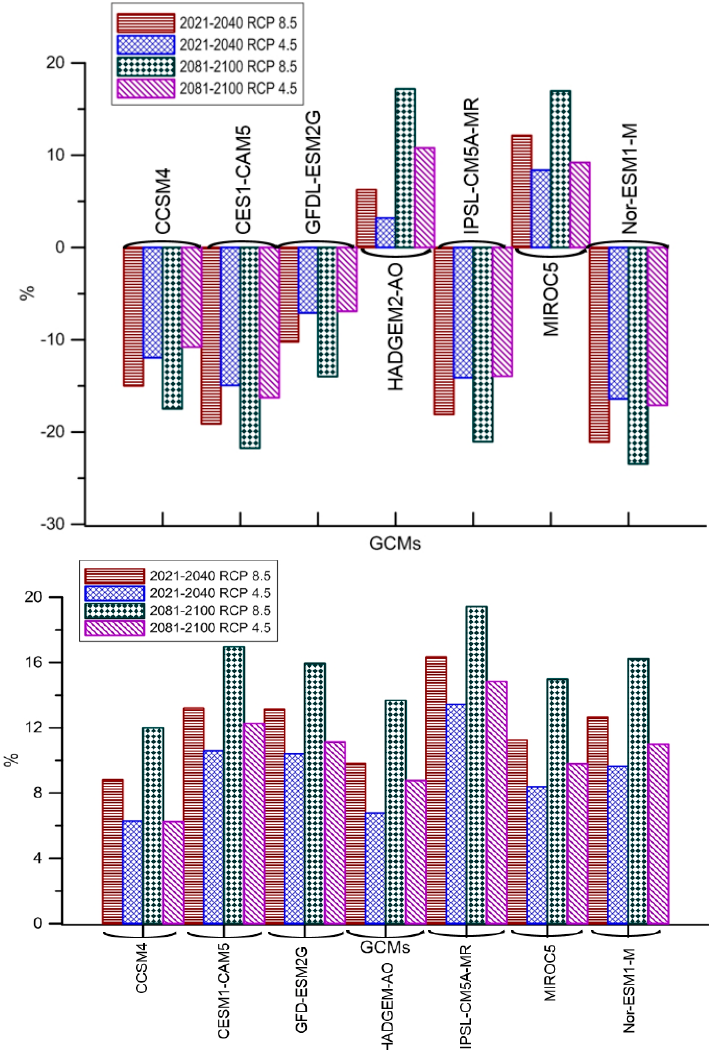
Figure 5. Projected change of evapotranspiration for a period 2021–2040 and 2081–2100 in dry ( top ) and wet season ( bottom ) of Gilgel Abbay watershed with reference to the baseline (1980–1999) under RCP 8.5 and RCP 4.5.